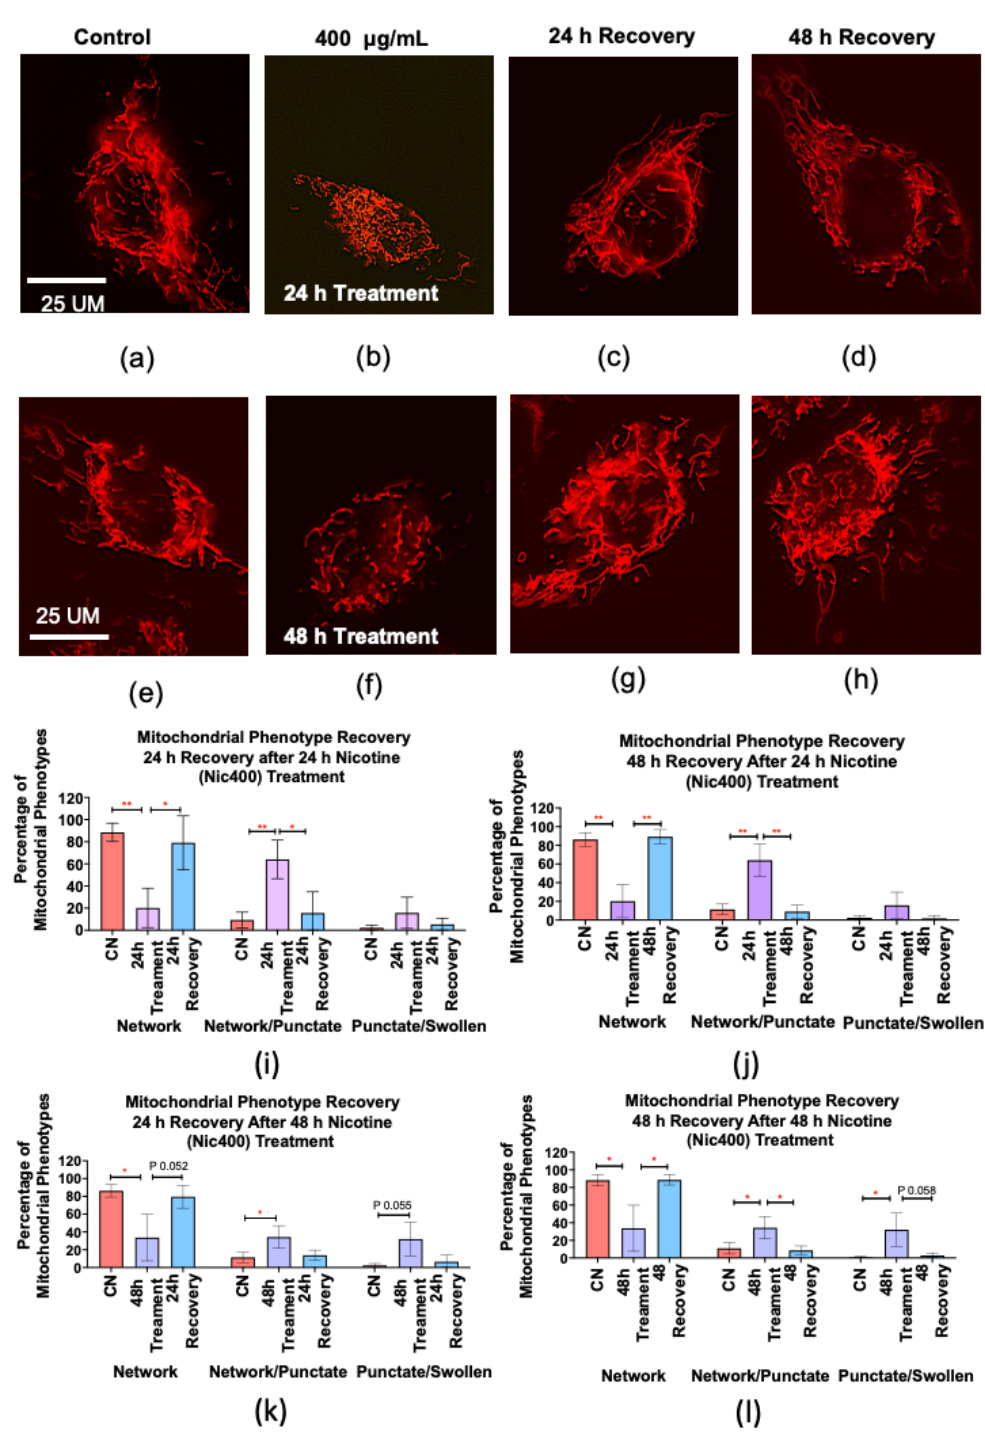
Figure 4. Mitochondrial morphology in nicotine treated keratinocytes returns to normal after 24 h and 48 h of recovery in culture medium. ( a – h ) Micrographs showing untreated controls, cells treated with nicotine, and cells that recovered 24 h or 48 h after treatment. ( i ) Mitochondrial morphology in keratinocytes treated for 24 h and after 24 h of recovery. ( j ) Mitochondrial morphology in keratinocytes treated for 24 h and after a 48 h recovery. ( k ) Mitochondrial morphology in keratinocytes treated for 48 h and after 24 h of recovery. ( l ) Mitochondrial morphology in keratinocytes treated for 48 hours and after 48 h of recovery. CN = Control Medium. All data are means +/ − the standard error of the mean for three independent experiments. * = p < 0.05, ** = p < 0 .01.